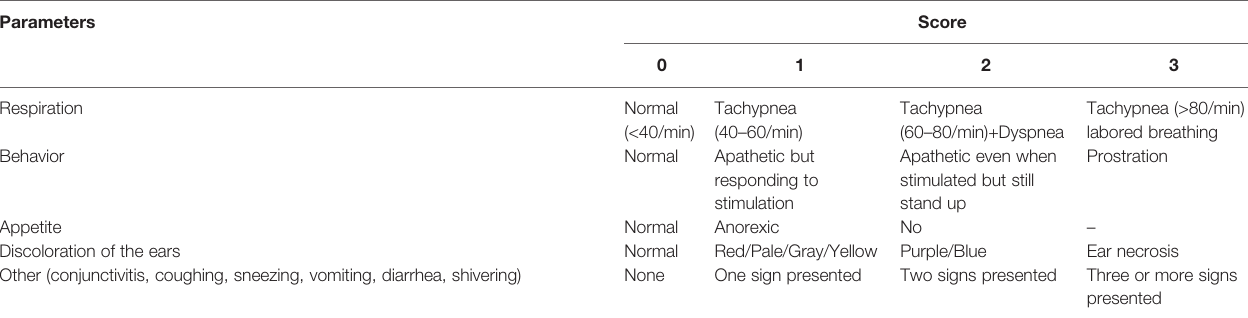
TABLE 2 | Criteria for clinical scoring following the HP-PRRSV-2 challenge.